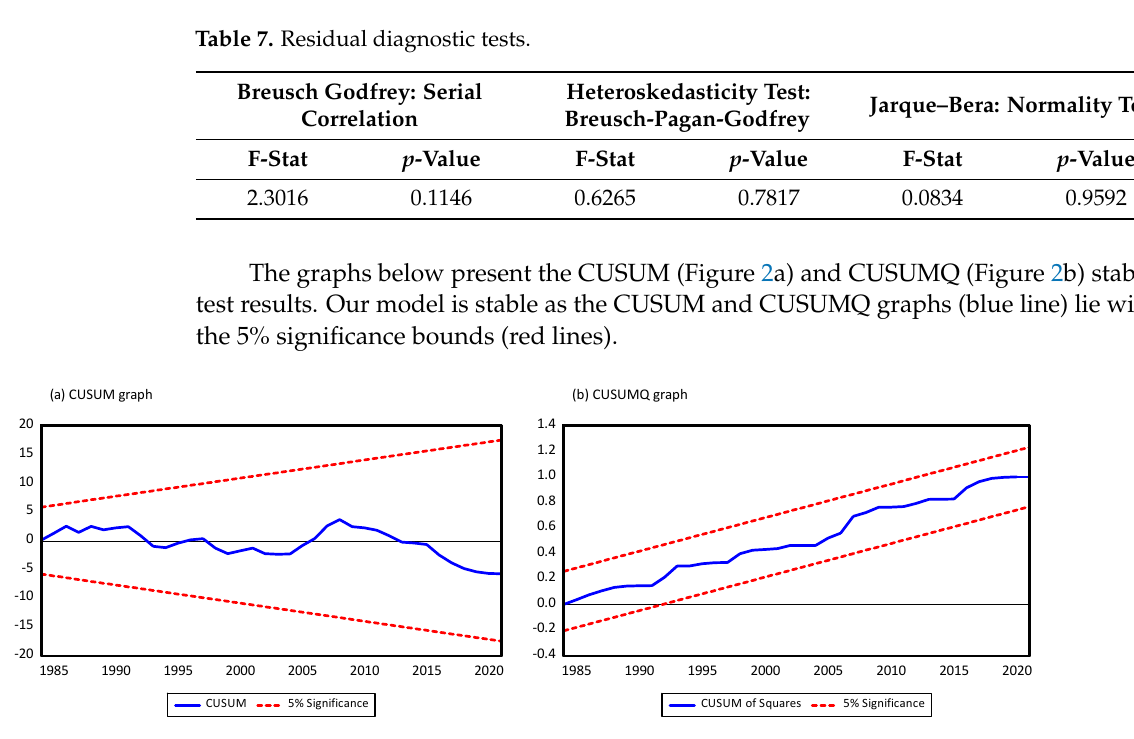
Figure 2. Stability test result.